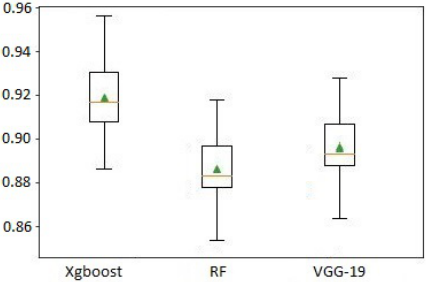
Figure 11. Mean accuracy value of shallow VGG with Xgboost and shallow VGG with RF and VGG19.